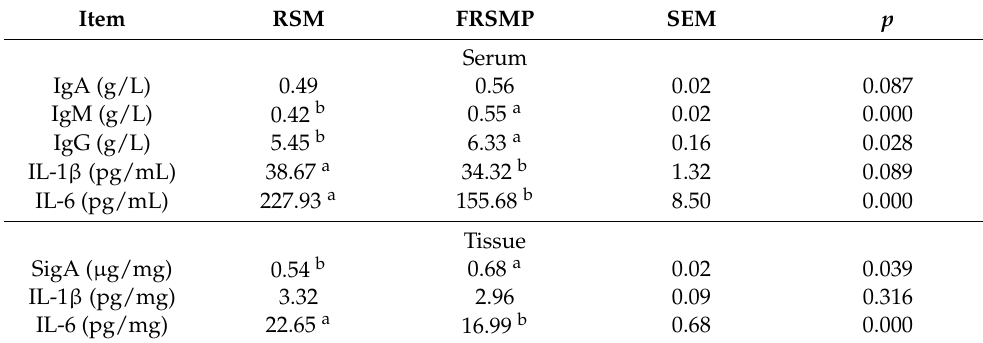
Table 5. Effects of the RSM and FPRSM on immunomodulation activity of the weaned rats in